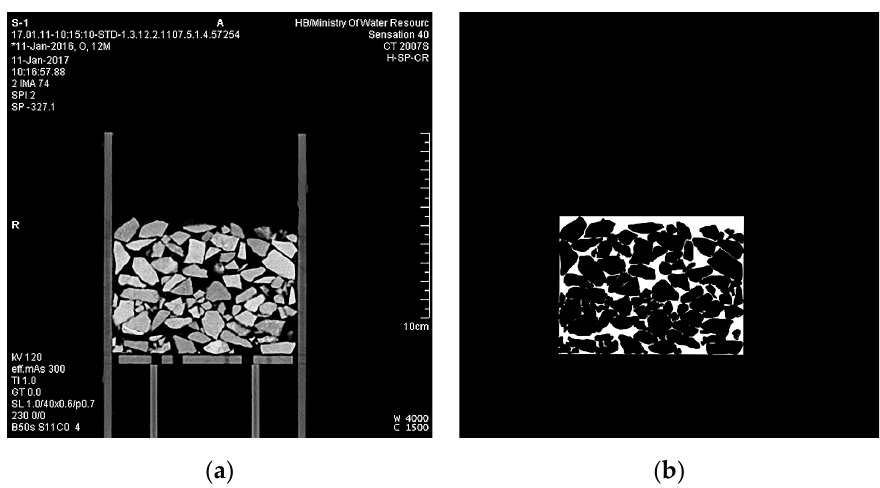
Figure 9. Image segmentation based on the SVM. ( a ) The original CT scanning image. ( b ) The image after segmentation. after